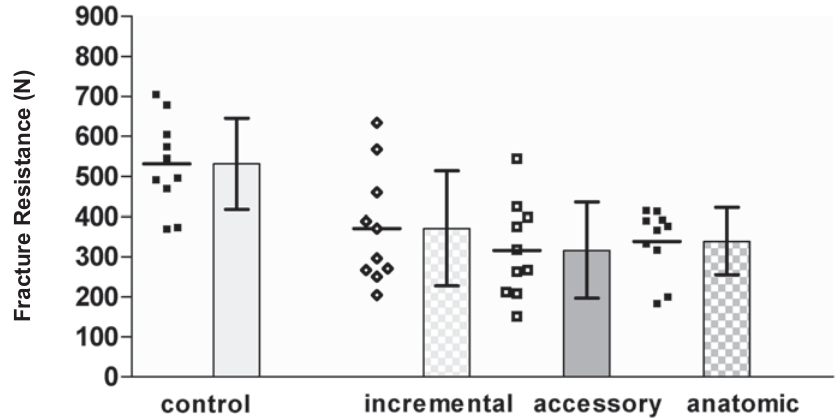
Figure 3- Points diagram around the mean and column graph (mean ± standard deviation) of the fracture resistance values (N) for the tested